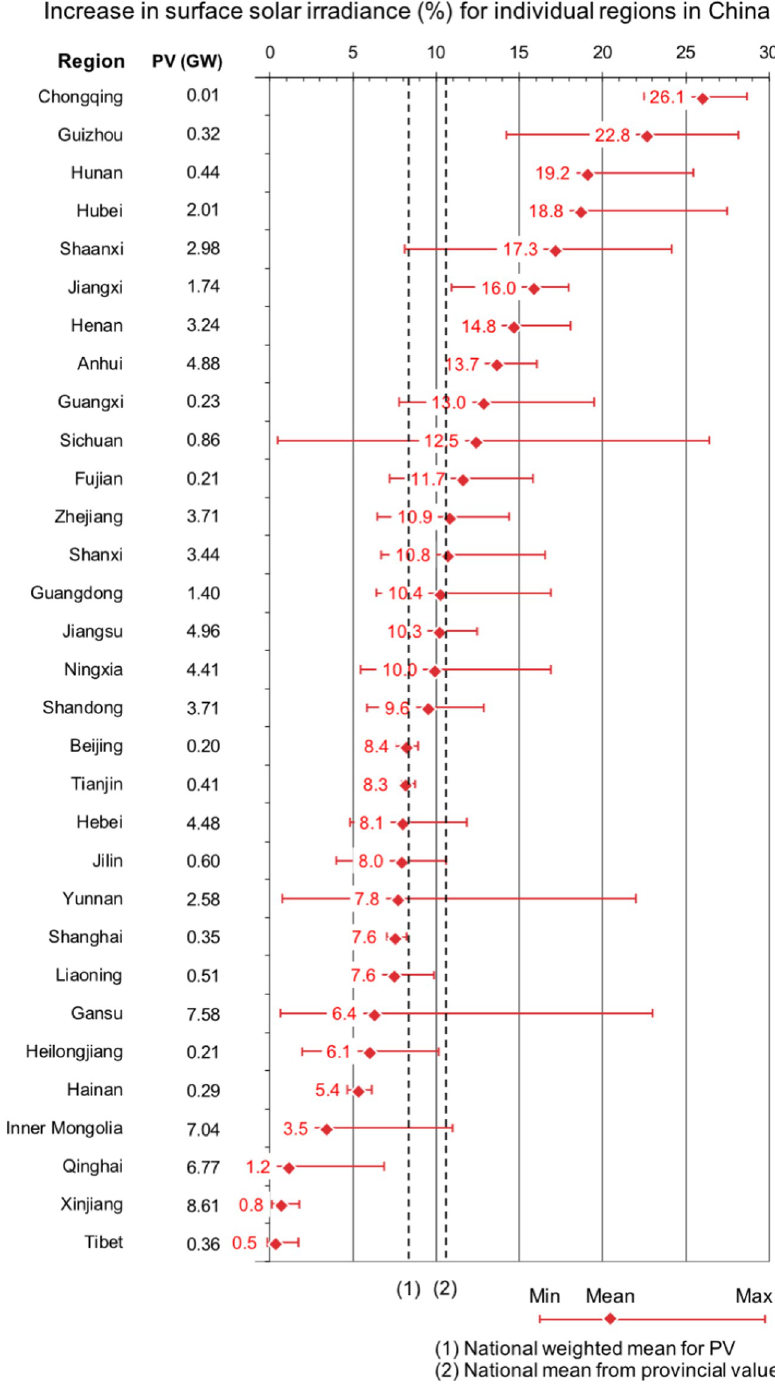
Fig 7. Increase in surface solar irradiance (min, max, mean %). For eliminating actual SO 2 , BC and OC emissions from all sectors. The mean province-specific increases in surface solar irradiance are area-weighted means. The national weighted mean for PV (8.3%) is weighted for province-specific PV capacities. The national mean from provincial values (10.6%) is the unweighted mean of all provinces. Right to the regions is the solar PV installed capacity (GW) per province as of December 2016. Data and material from [19, 24–26].